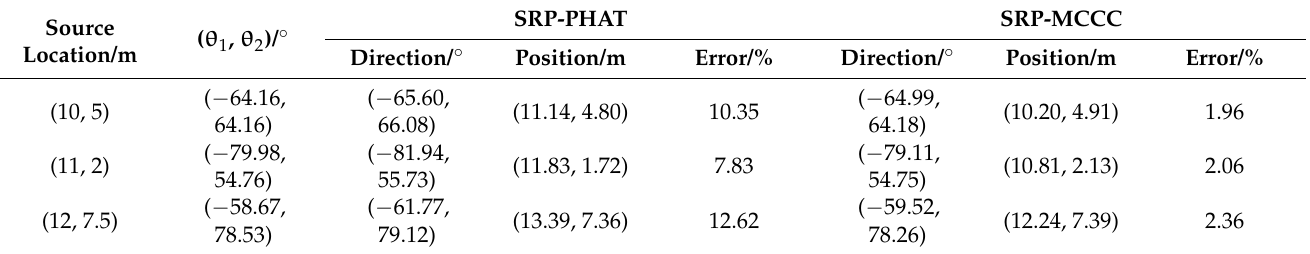
Figure 9. The location estimation experimental results of ( a ) SRP-PHAT and ( b ) SRP-MCCC when the sound source coordinate is (10, 5). Table 4. Localization results of SRP-PHAT and MCCC-SRP at different